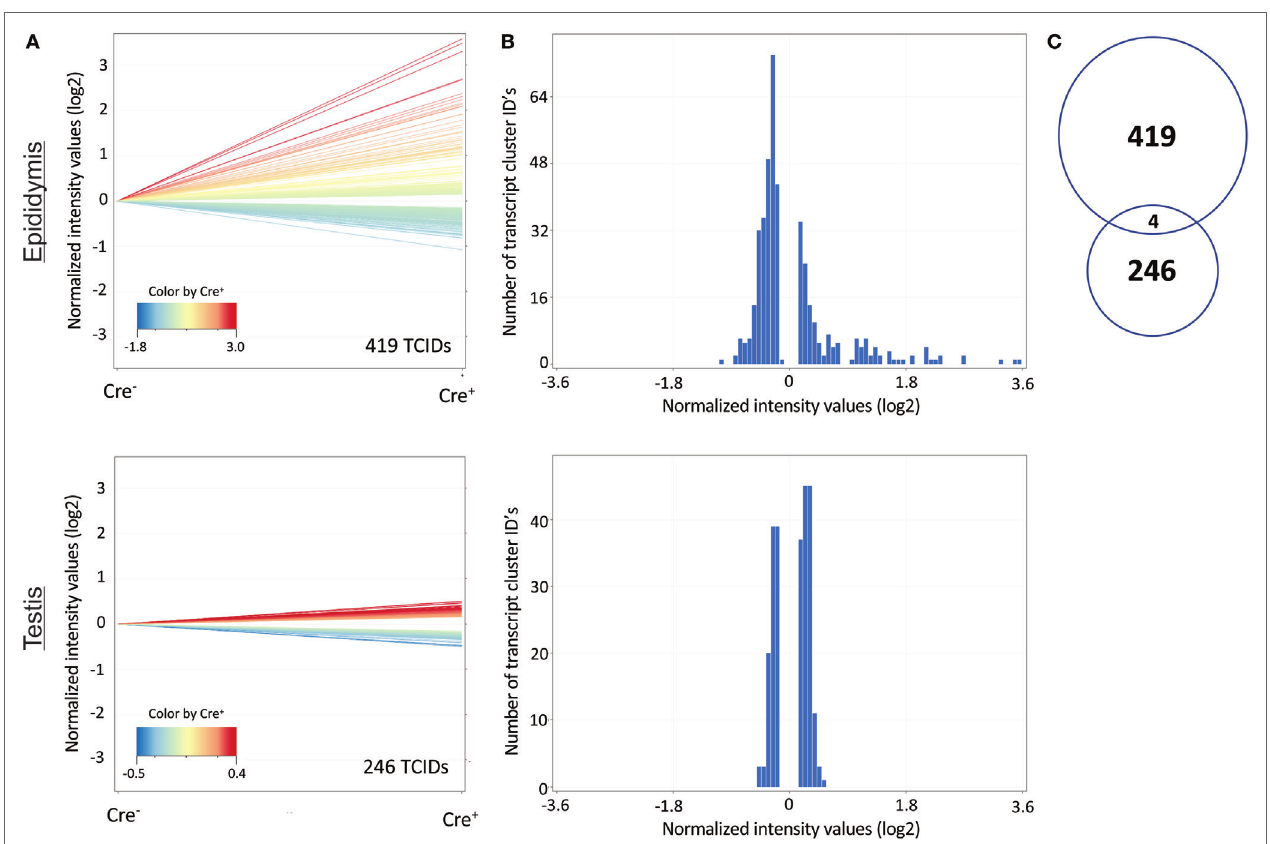
FigUre 6 | Distinct changes in the transcriptional profiles of the epididymis and testis of Tgfbr2 Δ DC mice. (a) Genes (denoted as transcript cluster IDs or TCIDs) were identified as differentially expressed in Cre + mice by moderated t -test with Westfall–Young multiple testing correction ( p < 0.05; N = 3). (B) Histograms depicting the patterns of altered gene expression in the two tissues, combining the magnitude of change (binned into 50 fold-change categories, X -axis) and the number of TCIDs ( Y -axis). (c) Venn diagram demonstrating negligible overlap (4 TCIDs) between the sets of differentially regulated genes in the epididymis (419 TCIDs) and testis (246